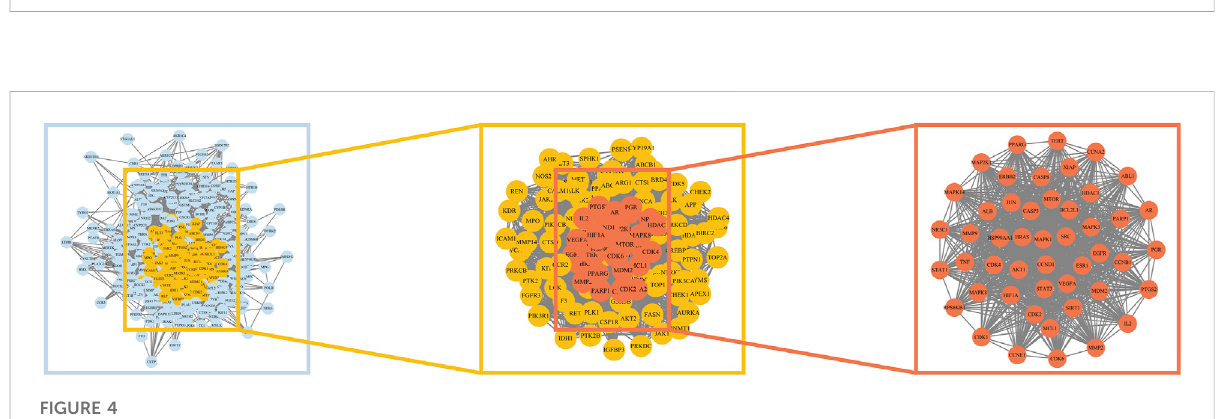
FIGURE 3 The 343 overlapping targets of LSYQ Decoction and BCa were identi fi ed by a Venn diagram.